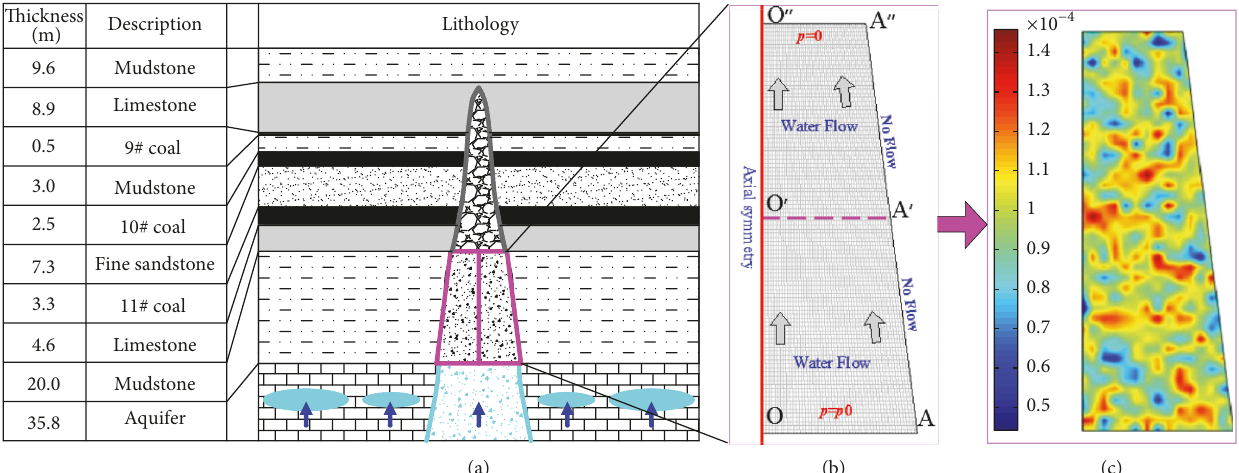
Figure 13: Model geometry and setup: (a) illustration of KCP and rock strata; (b) 2D simulation model; and (c) distribution of aperture opening based on Weibull